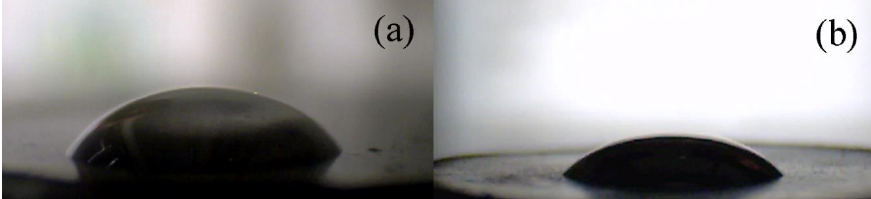
Figure 5. Images from CCD camera of the 5 µL PDMS droplets on the neat GO ( a ) and GO-PGMA ( b ).